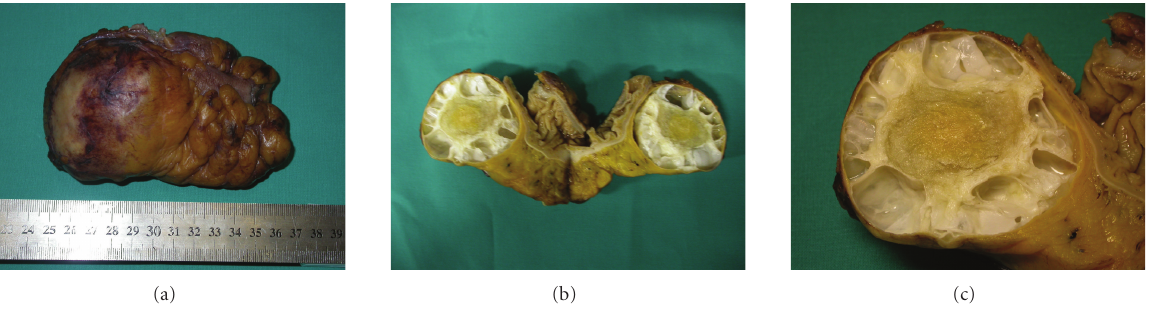
Figure 2: Surgical specimen.